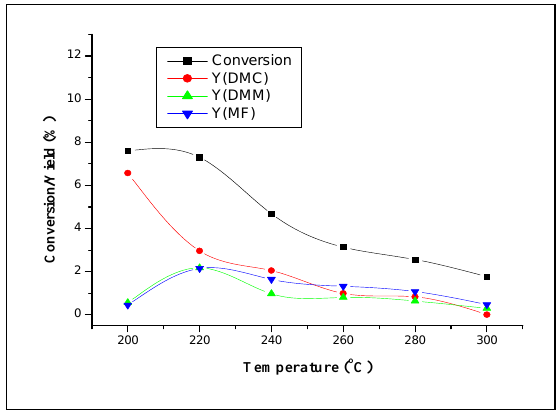
Figure 4. The dependence of the conversion and product yields on reaction temperature over Co PW O . Reaction conditions: MWHSV = 3.25 h -1 ; molar ratio 1.5 12 40 CH OH /CO = 1.9. 3 2